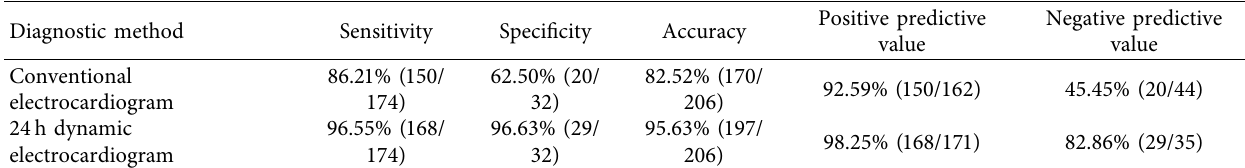
Table 3: Comparison of the diagnostic efcacy of the two groups of examination methods ( n / N